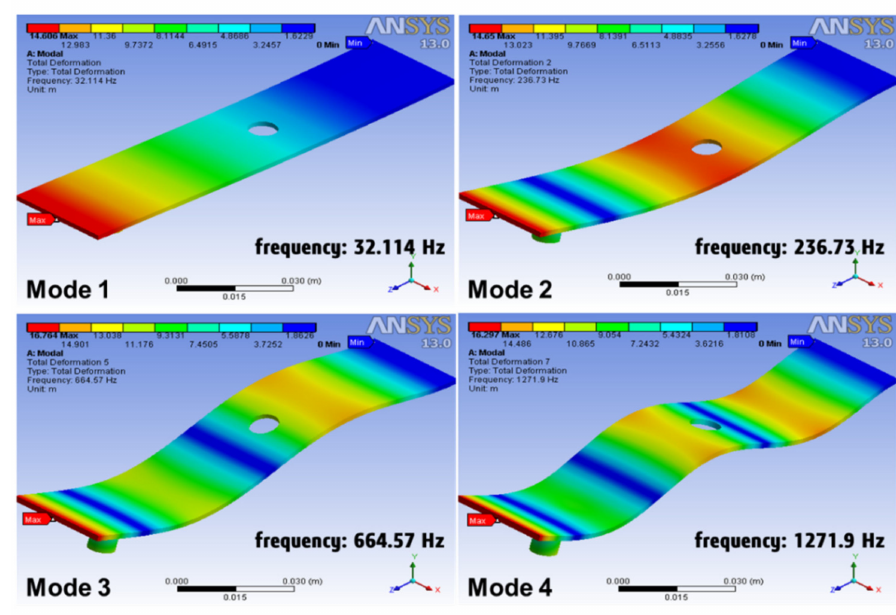
Figure 9. Mode shapes for a single specimen (W = 30 mm, D = 8 mm) in Group